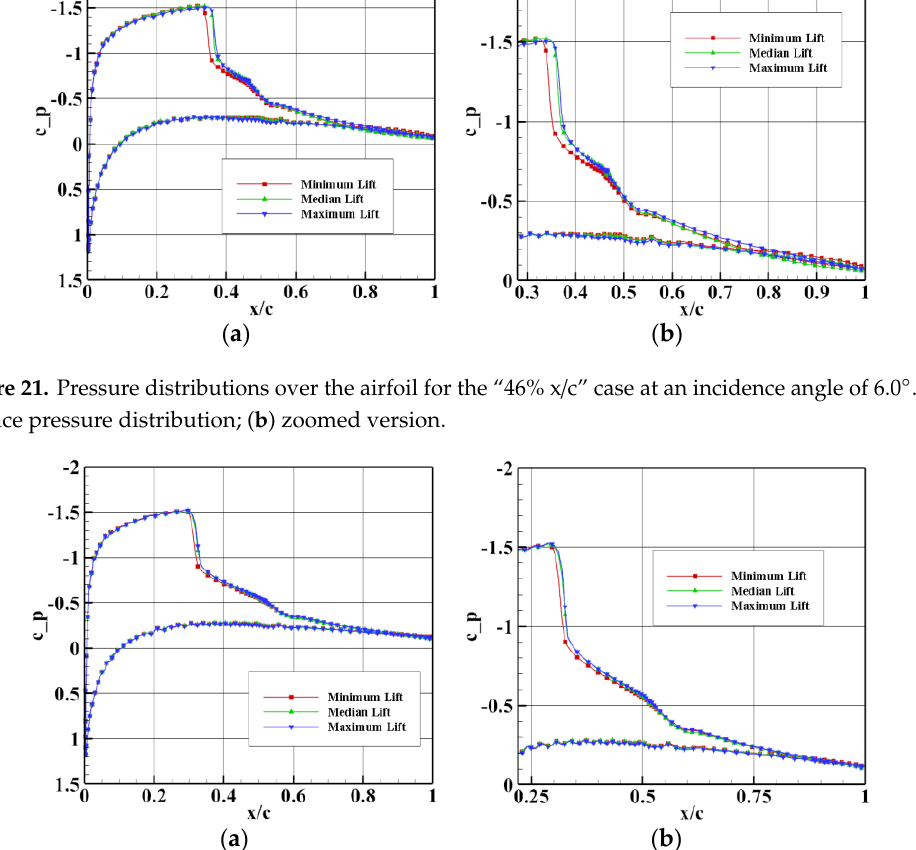
Figure 22. Pressure distributions over the airfoil for the “51% x/c” case at an incidence angle of 6.0°. ( a ) Surface pressure distribution; ( b ) zoomed version.